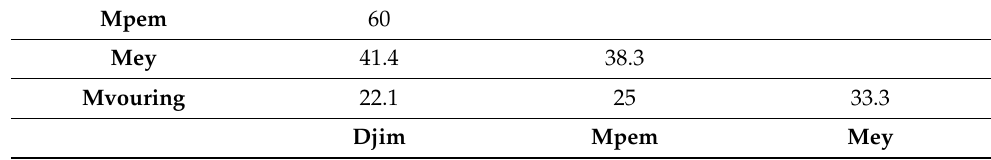
Table 5. Variation of the Jaccard ( q ) similarity index expressed as percentage of